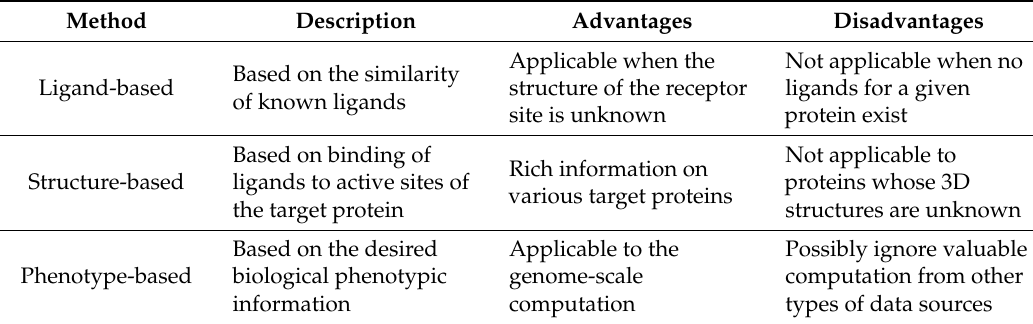
Table 1. The methods of drug–target interactions